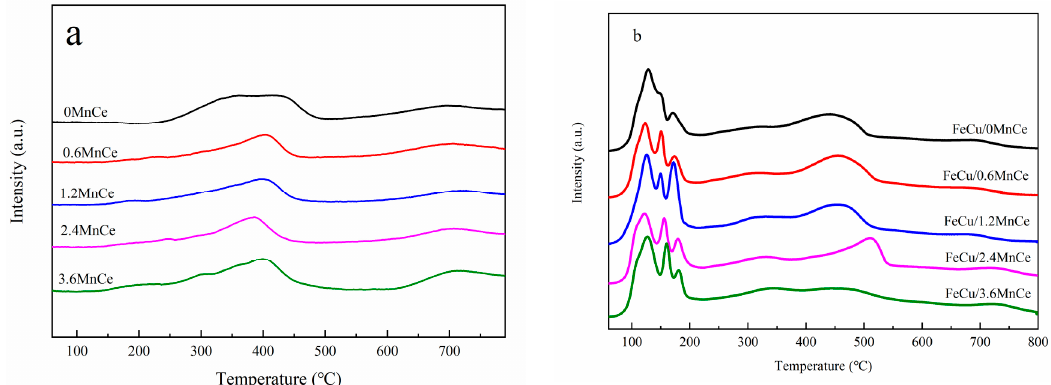
Figure 1. H 2 -TPR profiles: ( a ) fresh supports, ( b ) synthesized catalysts.